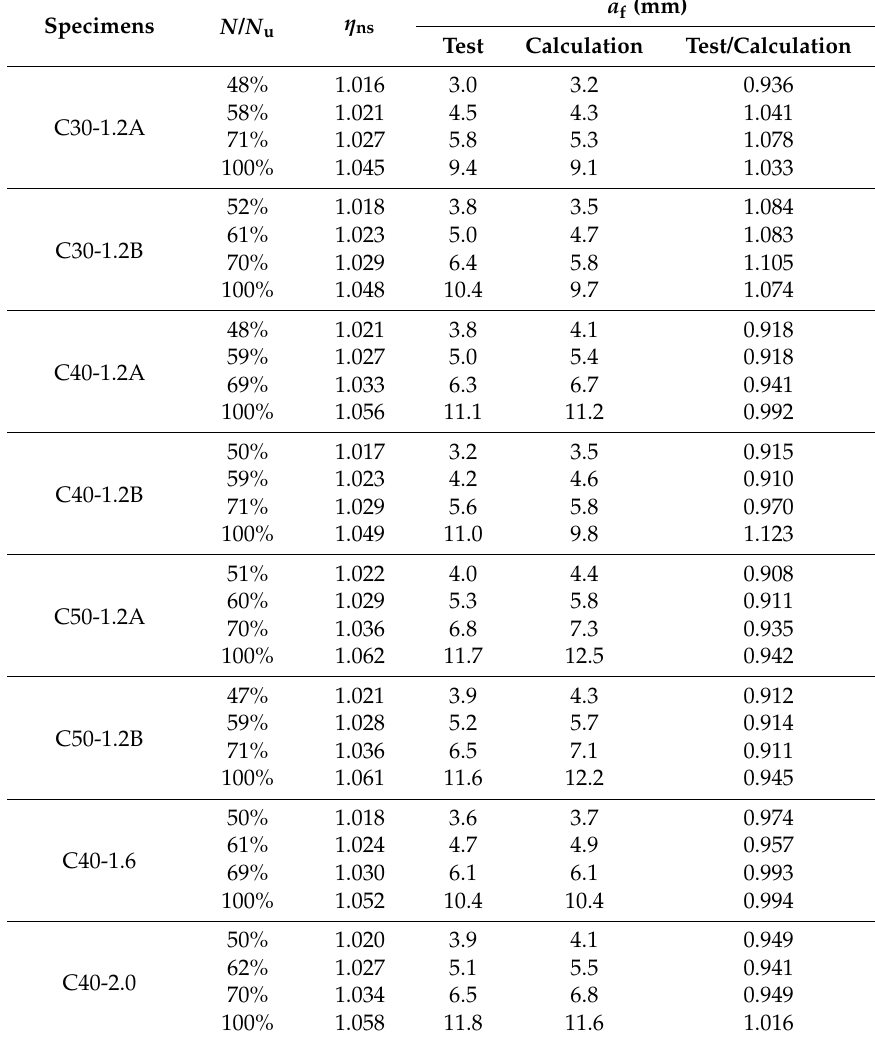
Table 6. The second-order effect factor and lateral